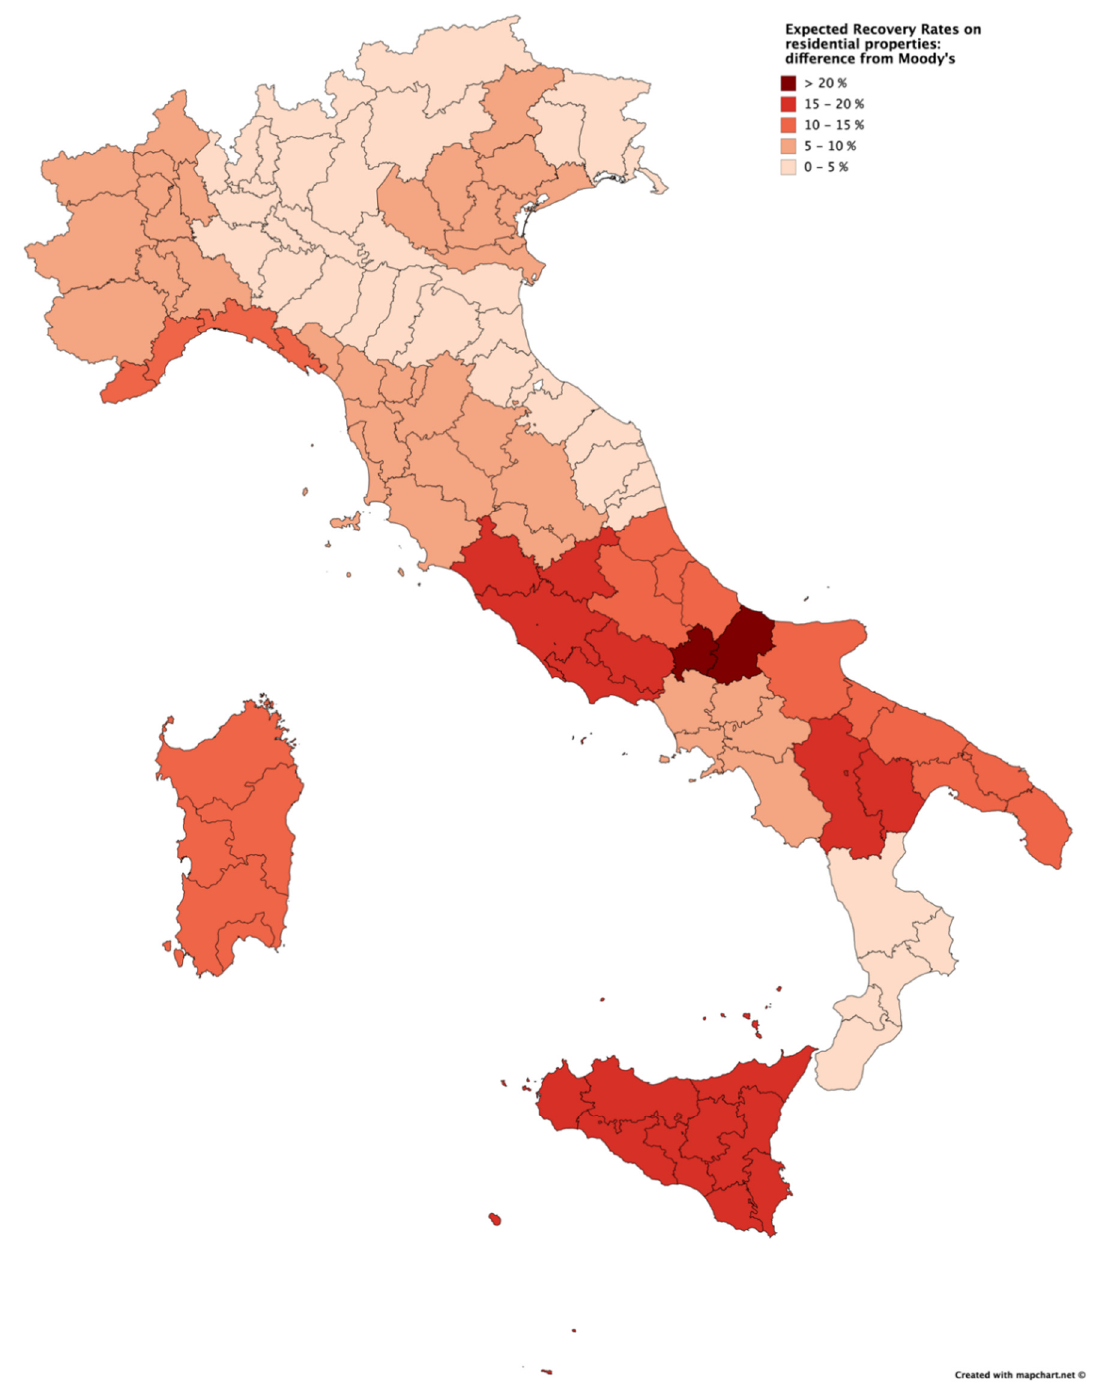
Figure 3. Expected recovery rates on residential properties: difference between Moody’s and our estimates. (Mapchart.Net estimates. (Mapchart.net 2020).